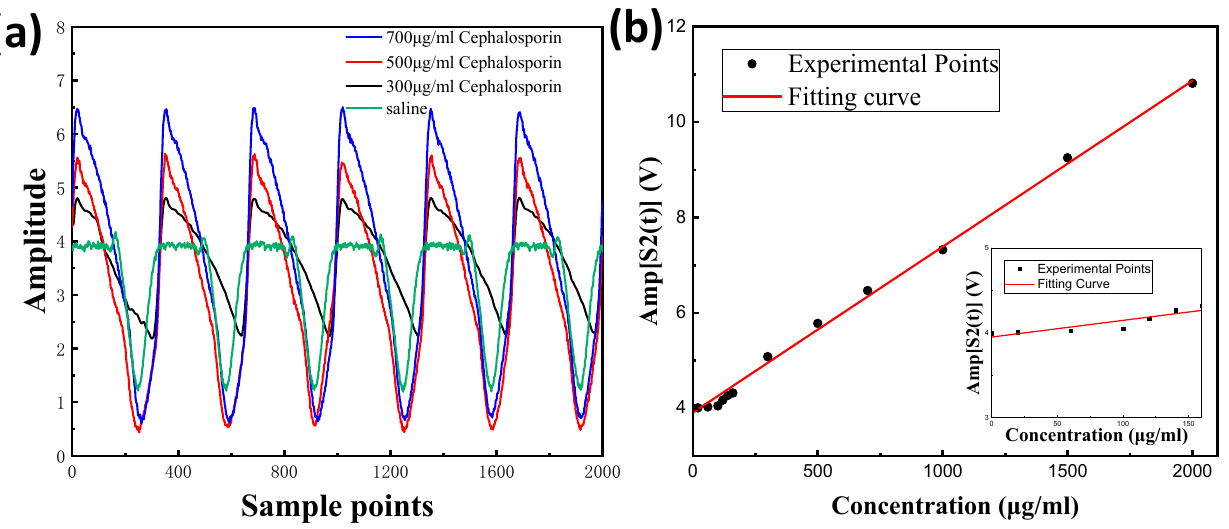
Figure 6. ( a ) Various cephalosporin concentrations represented by distinct 2f signals in systems with nanowire-PT; ( b ) 2f signal amplitude as a function of cephalosporin concentration.